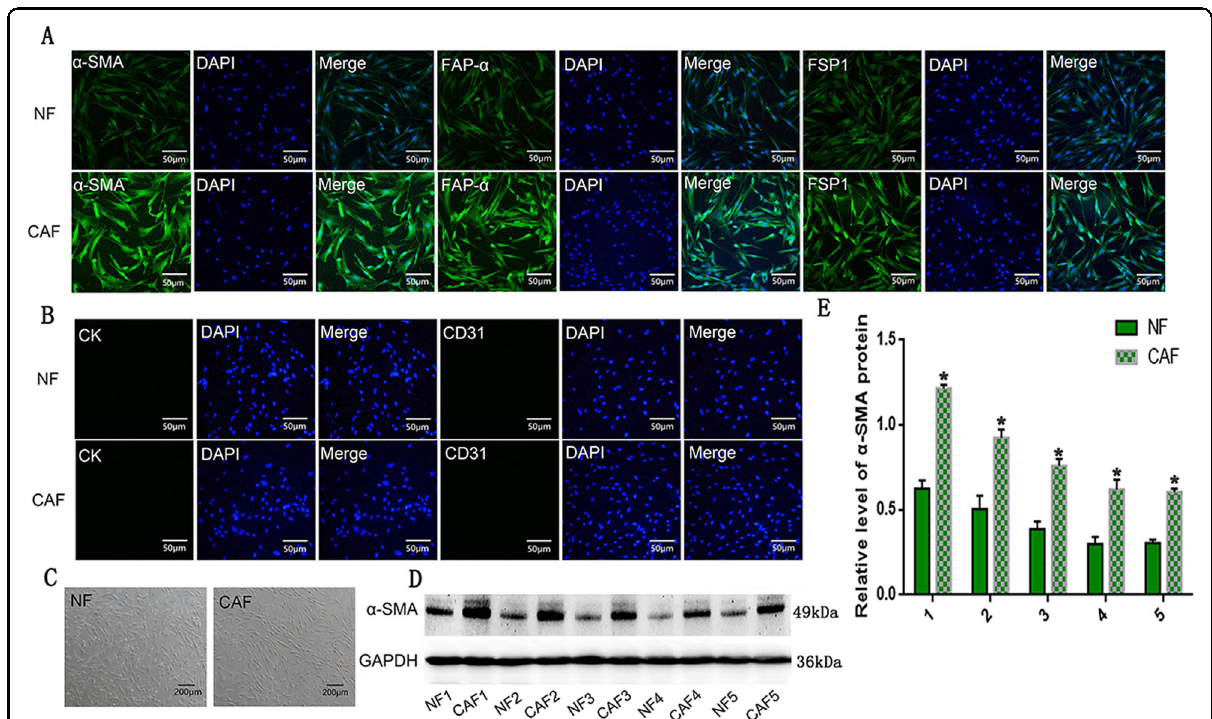
Fig. 1 Characterisation of primary CAFs and NFs. a , b Immuno fl uorescent (IF) staining for the fi broblast markers ( α -SMA, FAP- α and FSP1), the epithelial markers (CK) and the endothelial marker (CD31) in CAFs and NFs; scale bar: 50 μ m. c Phase-contrast micrograph showing the shape of CAF and NF; scale bar: 200 μ m. d , e Western blot analysis showed the expression of α -SMA in the CAF of seven samples. Data are representative images and numerical data are represented as the mean ± SD of each group of cells from three separate experiments. * p <